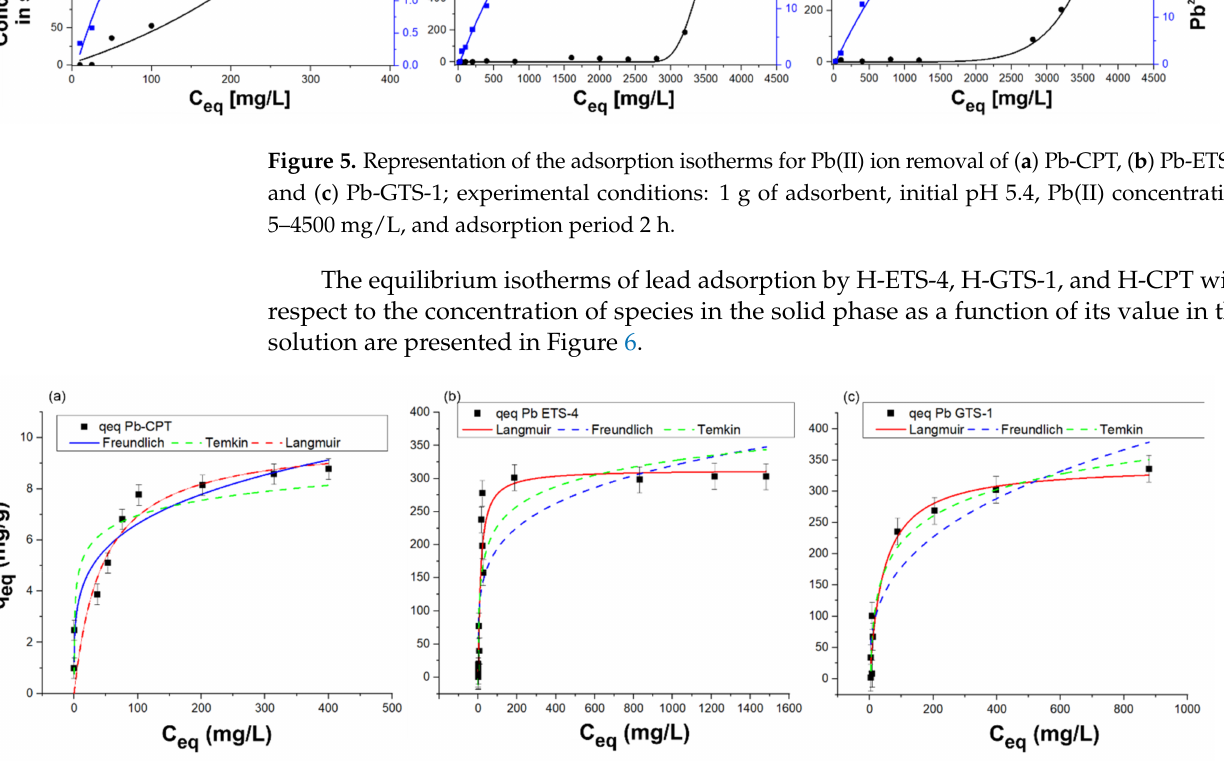
Figure 6. Equilibrium uptake isotherms of Pb(II) with ( a ) H-CPT, ( b ) H-ETS-4, and ( c ) H-GTS-1 in the liquid phase. The best fit of the experimental data ( q eq ) for H-CPT, H-ETS-4, and H-GTS-1 is given with solid